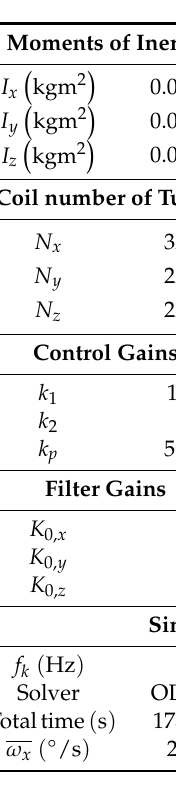
Table 1. Parameters for the simulations of Test Case 1 and Test Case2.